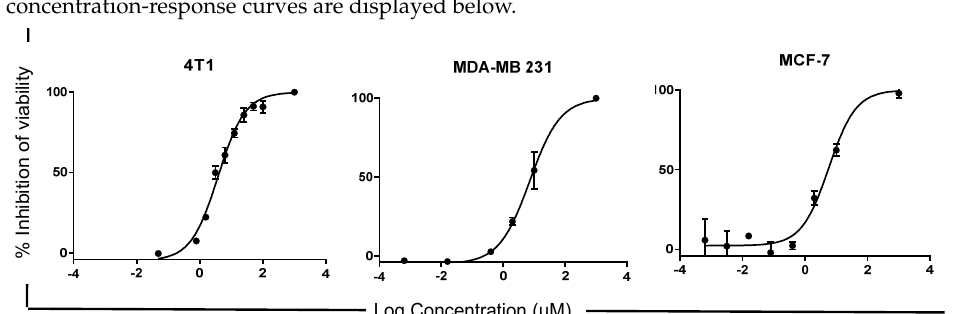
The IC 50 values were calculated based on the linear regression of the dose-log response curves after 48 h exposure to the peptide or carboplatin, determined by the MTT and resazurin assays. concentration-response curves are displayed below.